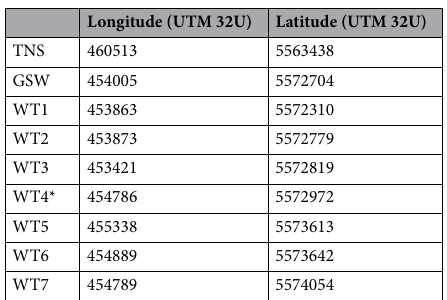
Table 1. Coordinates of seismic station TNS and GSW as well as of the WTs in UTM 32U projection. WT4* is used as the source for the modelling of the radiation from a single